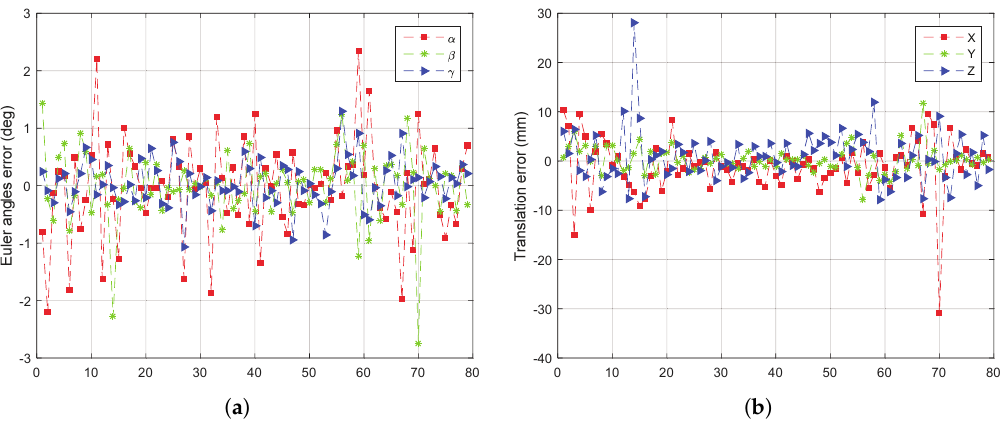
Figure 14. The error curve of ( a ) rotation and ( b ) translation of test